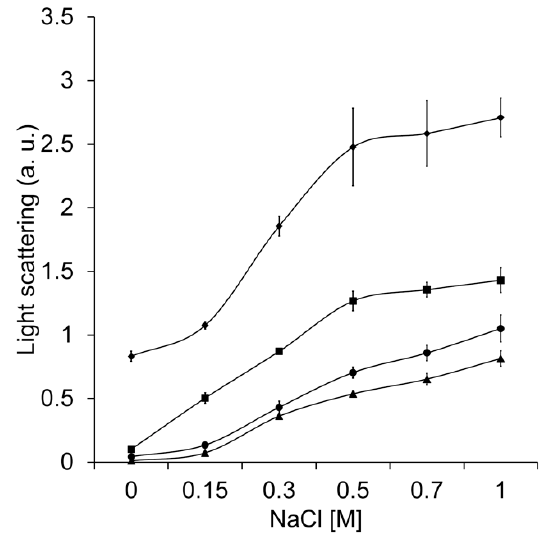
Figure 4. Increased ionic force (NaCl concentration) partially impaired unfolding activity. Heat denaturation of ADH (6 µM), measured by light sca tt ering at 360 nm, in the presence of BSA (6 µM) (rhomboids), Hsp31 (6 µM) (squares), CAT-3 (3 µM) (triangles), and TDC3 (6 µM) (circles) at different NaCl concentrations (0, 0.15, 0.3, 0.5, 0.7, and 1 M) in 10 mM phosphate buffer, pH 7.8. Average of the final light-scattering value from three independent